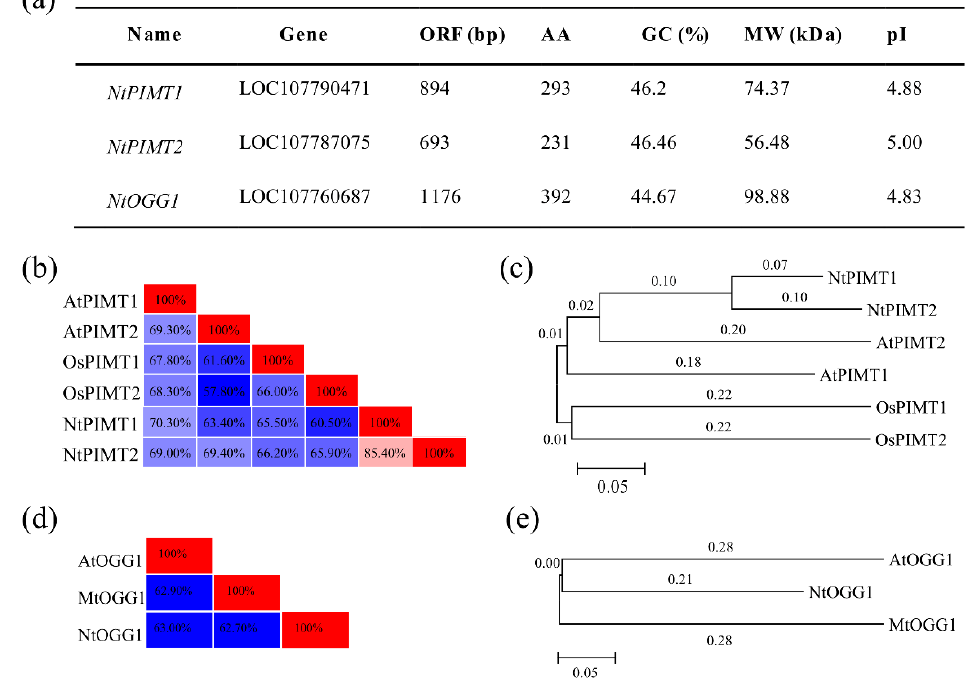
Figure 1. Characteristics of amino acid sequences of PIMT and OGG1 genes. ( a ) The basic information of NtPIMT and NtOGG1 genes. Sequence similarity analysis of ( b ) PIMT and ( d ) OGG1 genes using DNAMan. Colour scale represents sequence similarity. Phylogenetic tree of ( c ) PIMT and ( e ) OGG1 genes using the neighbour-joining method with default parameters. Abbreviations: ORF—open reading frame; AA—amino acids; MW—protein molecular weight; pI—protein isoelectric point.